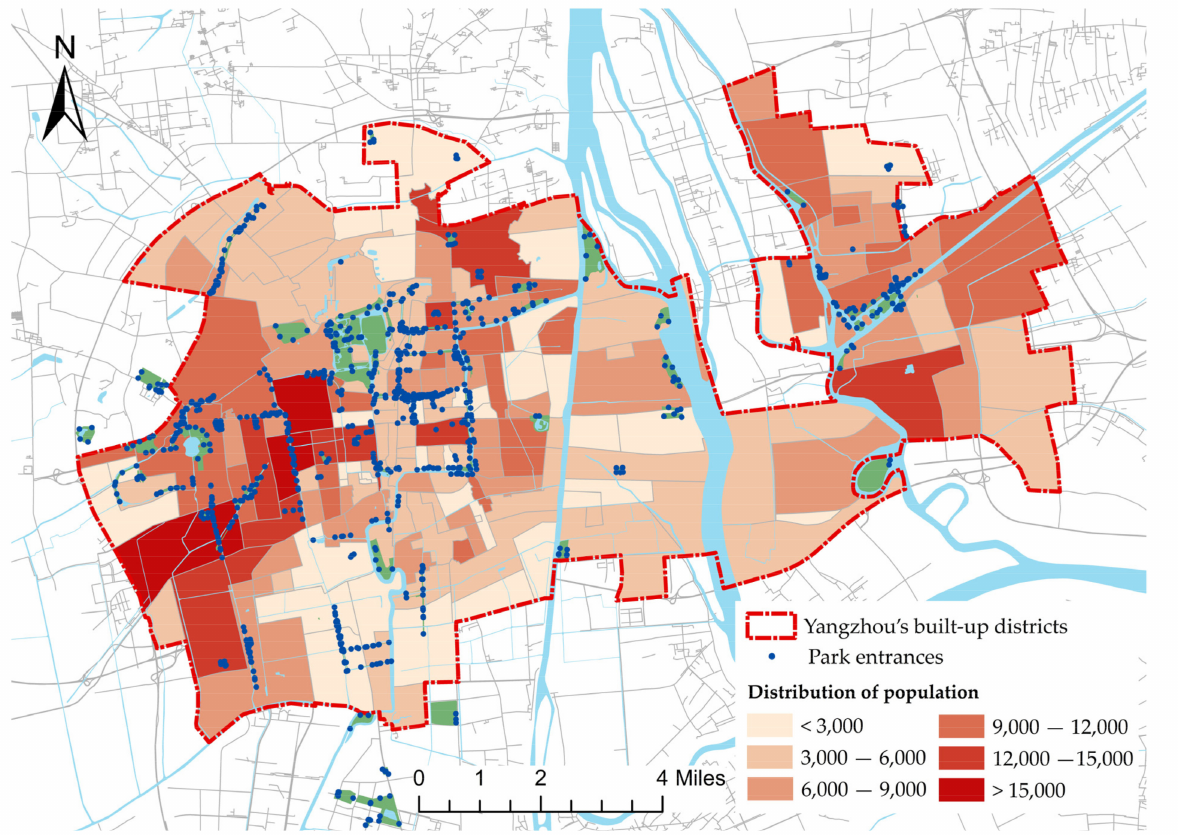
Figure 4. Park entrances and population